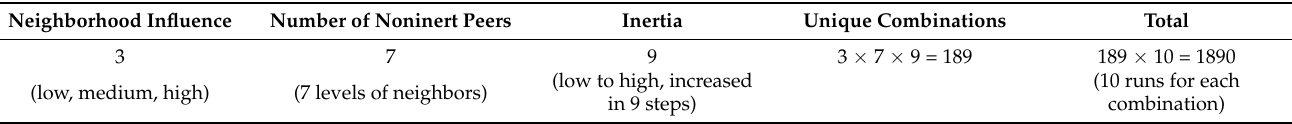
Table 1. ABM experimentation